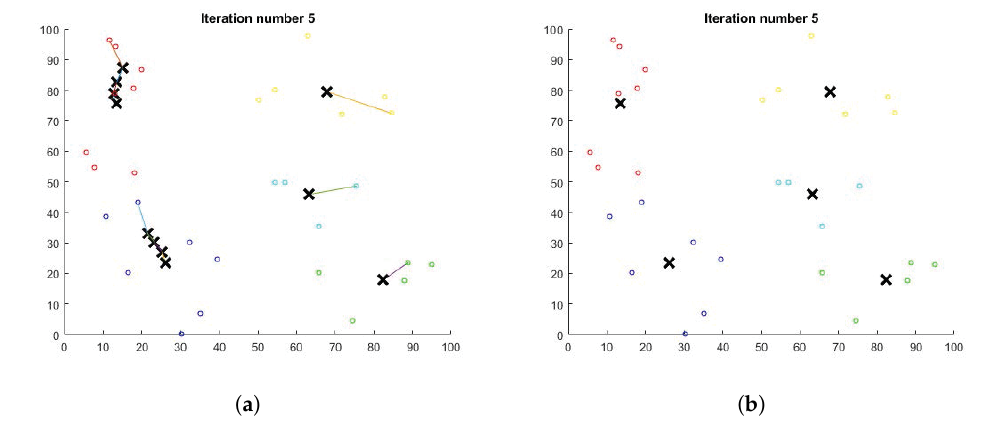
Figure 7. Change in position of centroids as K-Means clustering algorithm progresses. ( a ) shows the transition of cluster centroids (shown as crosses) up to iteration 5, whereas, ( b ) shows only the final stable state after iteration 5. In the figures, cross-sign represents cluster centroids and the colored-circle-sign represents the user associated with the same group or